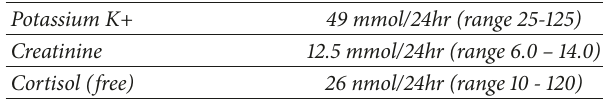
Table 4: Urinary electrolytes/cortisol (24hr